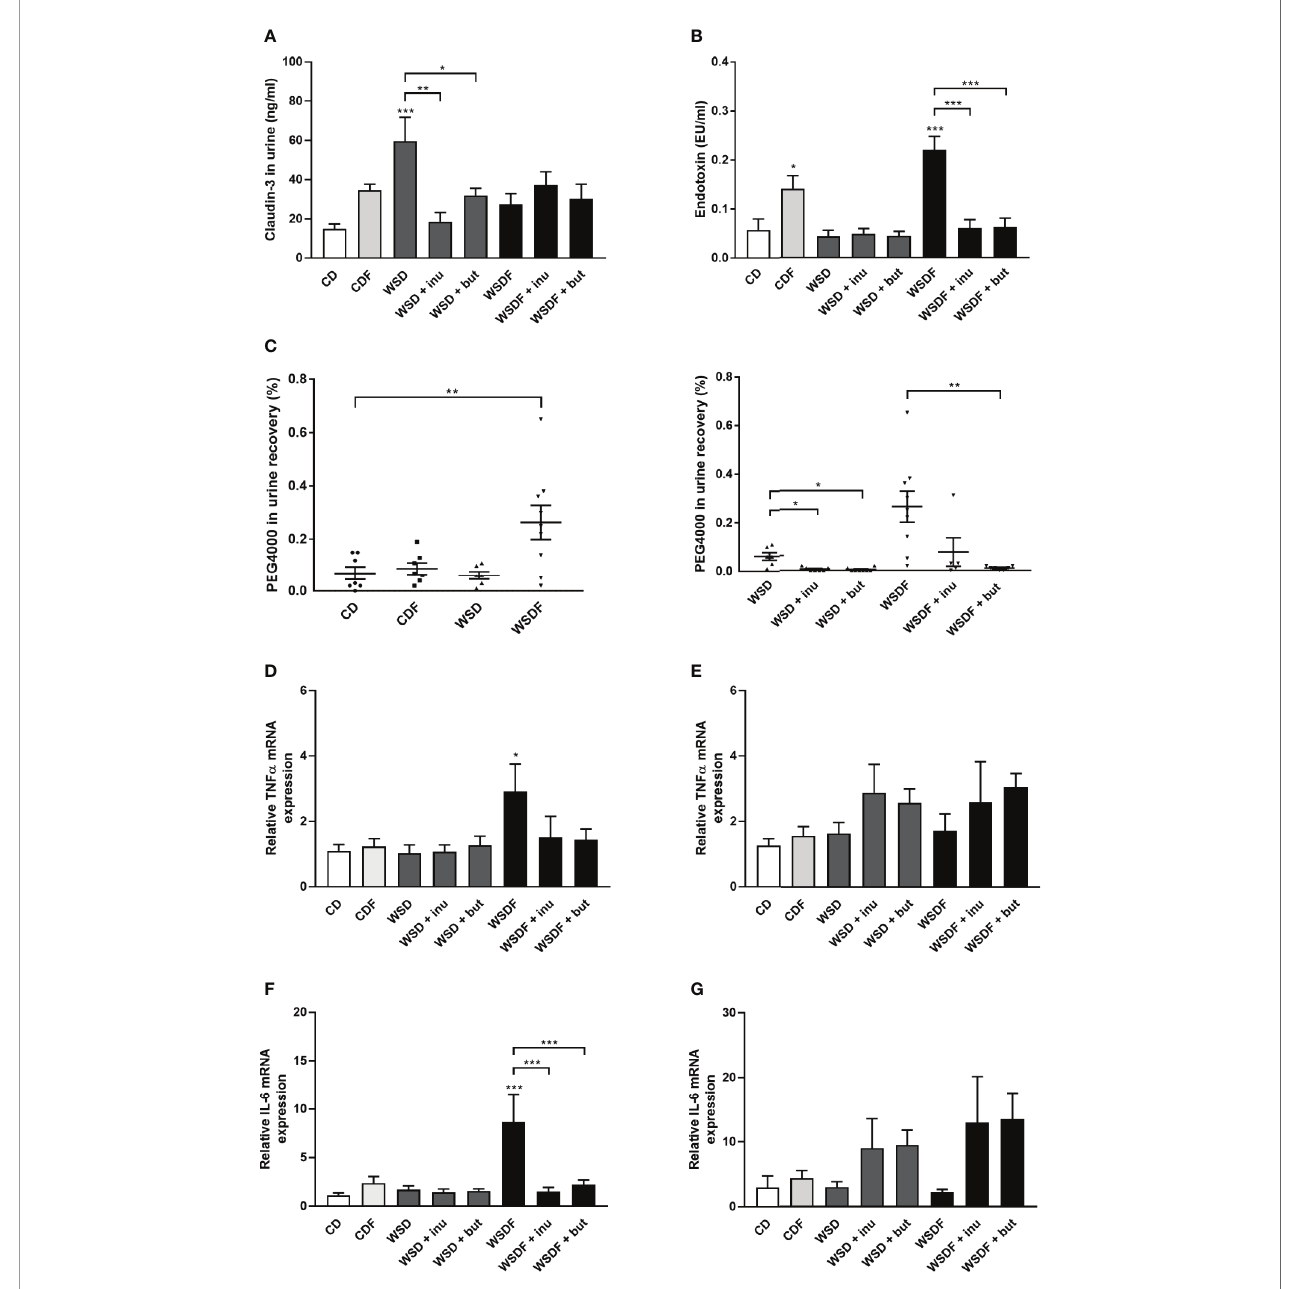
FIGURE 7 | Supplementation with inulin and sodium butyrate improves intestinal permeability and in fl ammation. C57BL/6 mice fed different diets as described in Figure 1 . (A) Intestinal permeability was determined by claudin-3 level in the urine. (B) Endotoxin concentrations in the portal venous plasma. (C) PEG4000 recovery in urine in percent of orally administered PEG4000 by gavage. Relative mRNA expression level of TNF - a (D) and IL-6 (F) in the ileum and TNF- a (E) and IL-6 (G) in the colon determined by quantitative RT-PCR. Data are presented as means +/- standard error of the mean (SEM) (n = 6 – 10). Statistical analysis was performed by one-way ANOVA with Dunnett´s or Sidak´s post-test or by Kruskal-Wallis-test for non-parametric data with a Dunn ’ s post-test. Signi fi cant differences are indicated as *p-value < 0.05; **p-value < 0.01; ***p-value < 0.001. PEG4000, polyethylene glycol